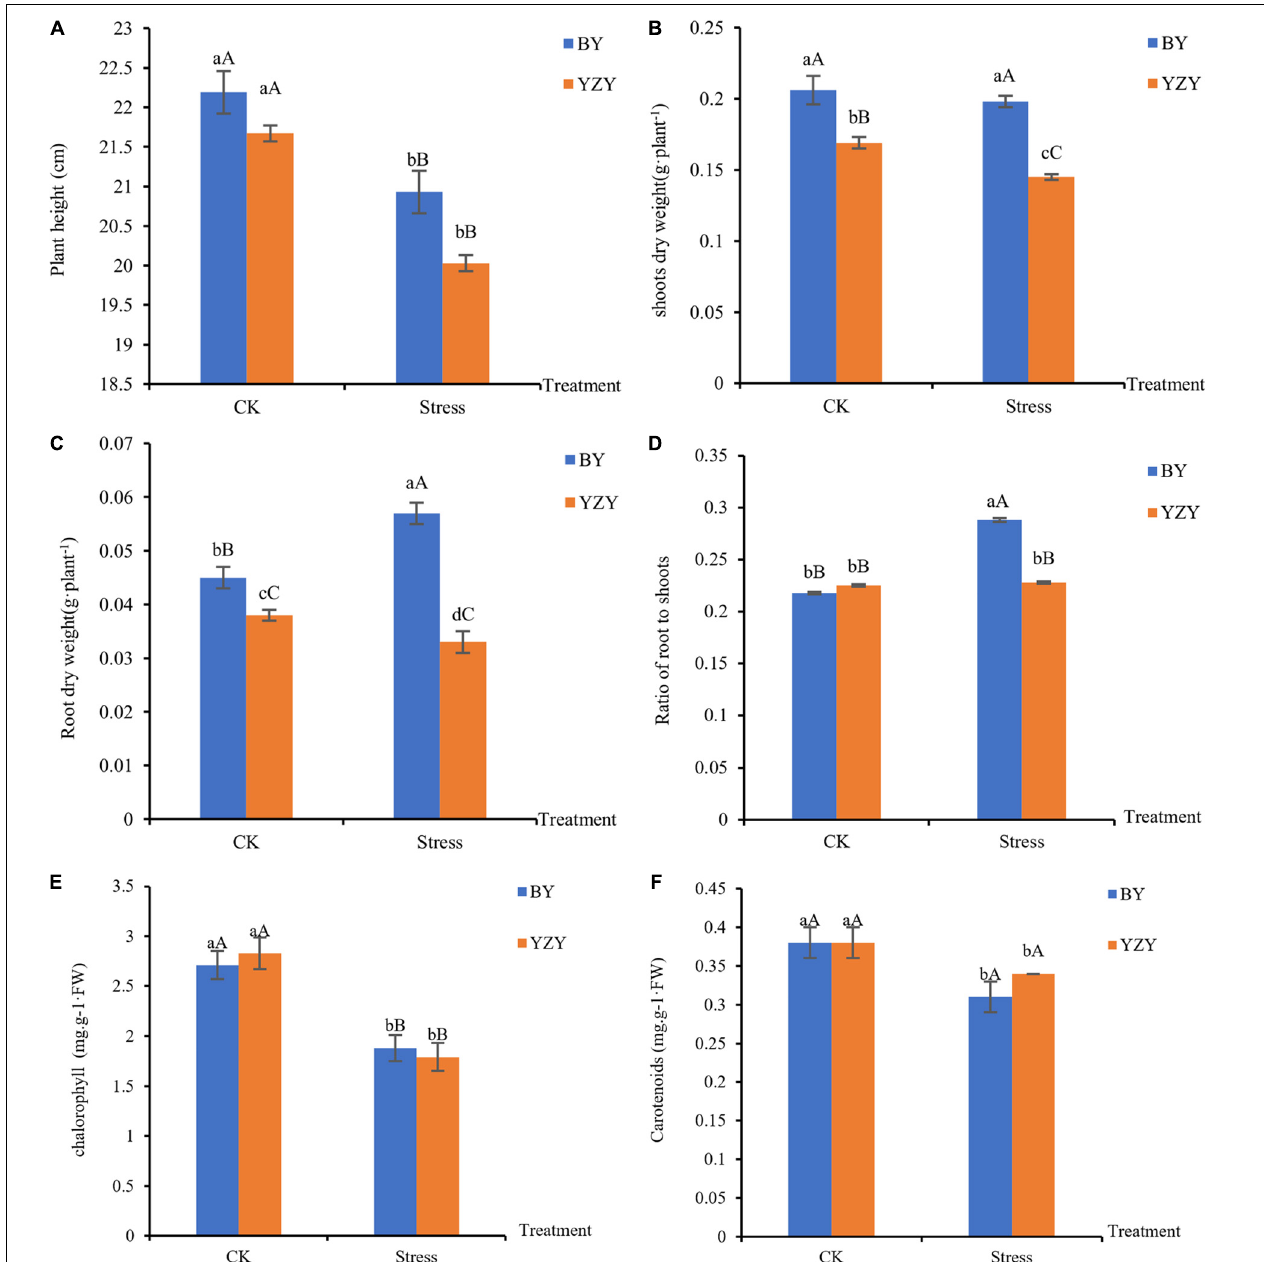
FIGURE 1 | Oat seedlings growth phenotypes of Baiyan7 (BY) and Yizhangyan4 (YZY) during saline-alkali stress. (A) Plant height (cm), (B) shoots dry weight (g plant − 1 ), (C) root dry weight (g plant − 1 ), (D) ratio of root weight to shoot weight, (E) chlorophyll content in the leaves (mg · g − 1 · FW), and (F) carotenoids content in the leaves (mg · g − 1 · FW). Different lowercase letters indicate significant differences among the treatments ( P < 0.05) and different capital letters indicate significant differences ( P <